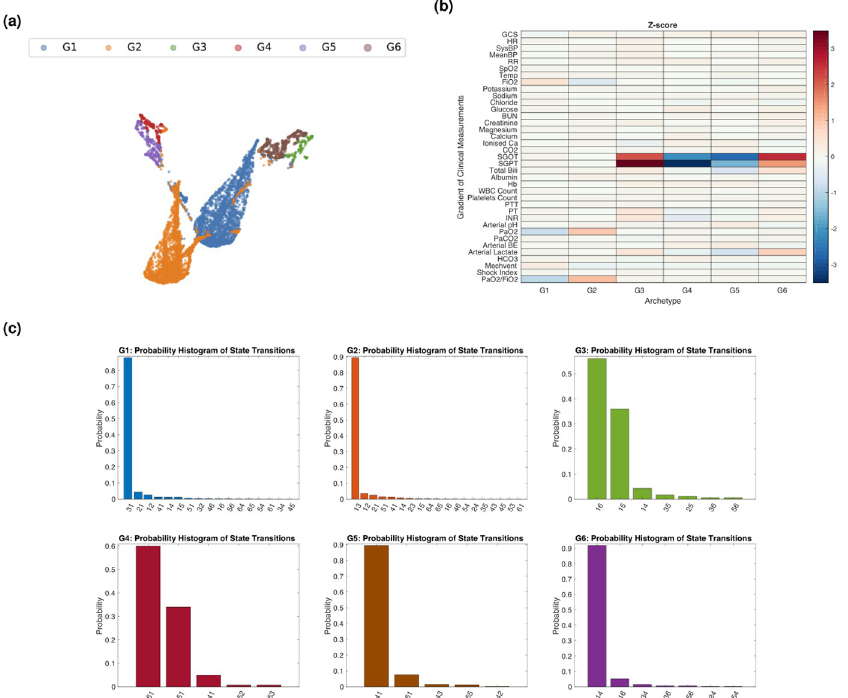
Fig 7. ( A ) Visualization (using low-dimensional UMAP embedding) of the six derived gradient groups. ( B ) Z-score analysis of the gradients of clinical measurements (row) of each gradient group (column). Entries approaching red indicate that the gradient of the clinical readings are expressed in the corresponding gradient groups, and entries closer to blue indicate that the gradient of the clinical readings are suppressed in corresponding gradient groups. ( C ) Probability histogram of state transitions of each gradient